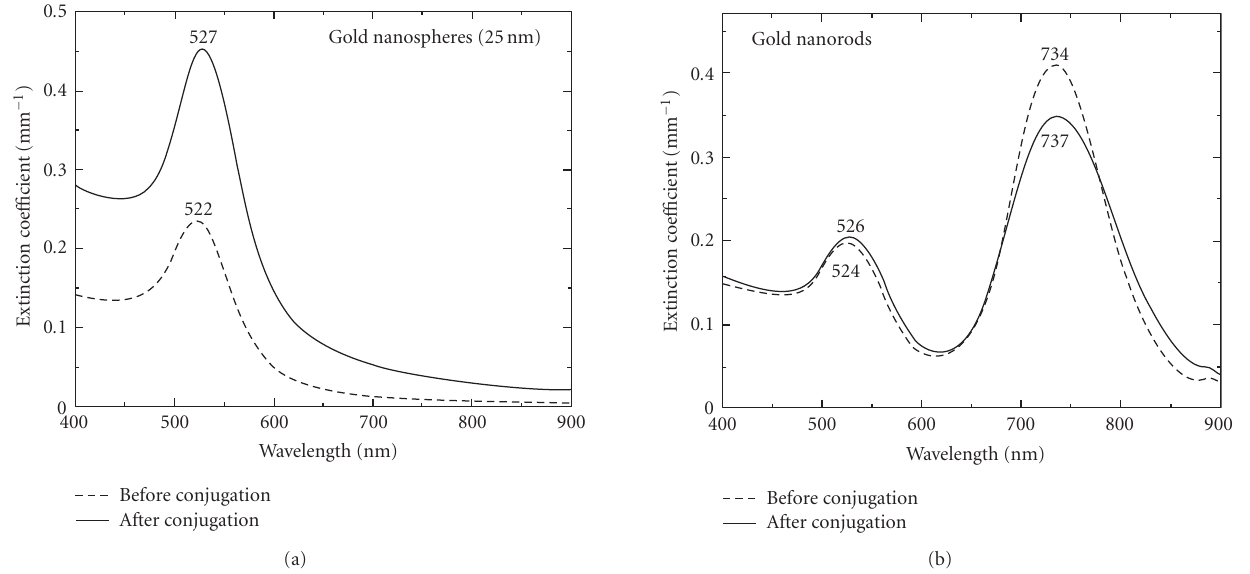
Figure 6: Extinction spectra before and after incubation of HER81 with (a) gold nanospheres, (b) gold nanorods. In both cases, a red shift in plasmon band(s) occurs after incubation with the antibody signifying successful bioconjugation.